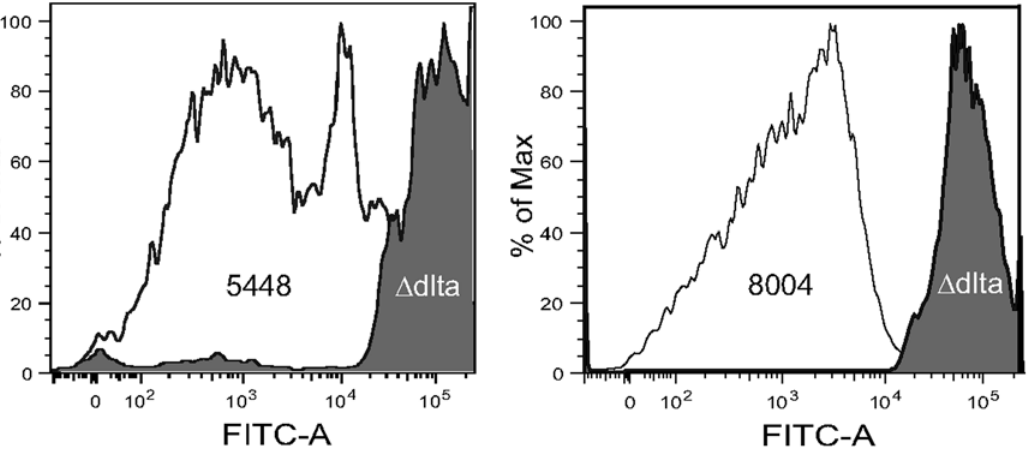
Figure 4. Relative levels of C3 deposition on WT and D dltA mutant bacteria. WT bacteria (open histogram) and D dltA mutants (filled histogram) were stained with a fluorescein-labeled antibody against human C3 and analyzed by flow cytometry.